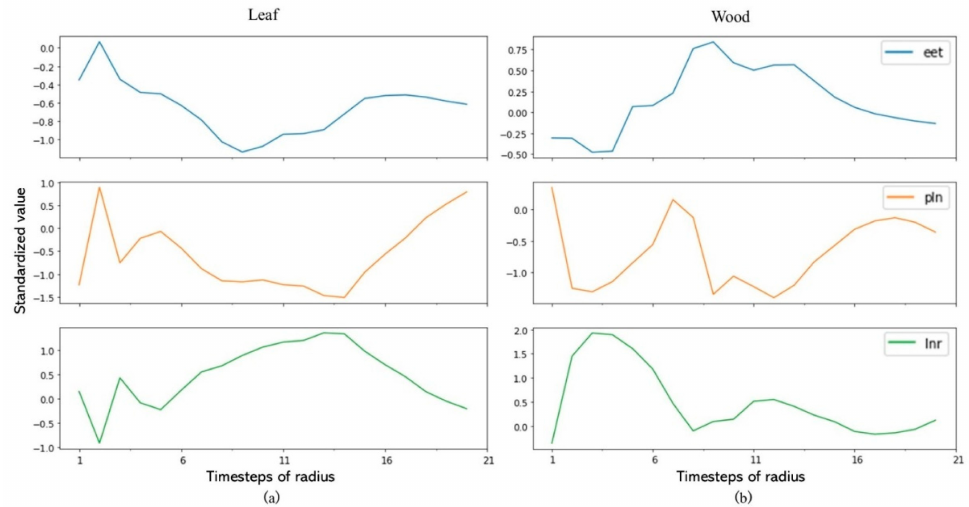
Figure 3. Time series of a leaf ( a ) and wood ( b ) point from a cloud using multiple radius nearest neighbors; eet: eigentropy; pln: planarity; lnr: linearity; the Y -axis is the standardized value of each feature; the X -axis is the timesteps of radius; here we have 20 radius or timesteps, then the value of X ranges from 1 to